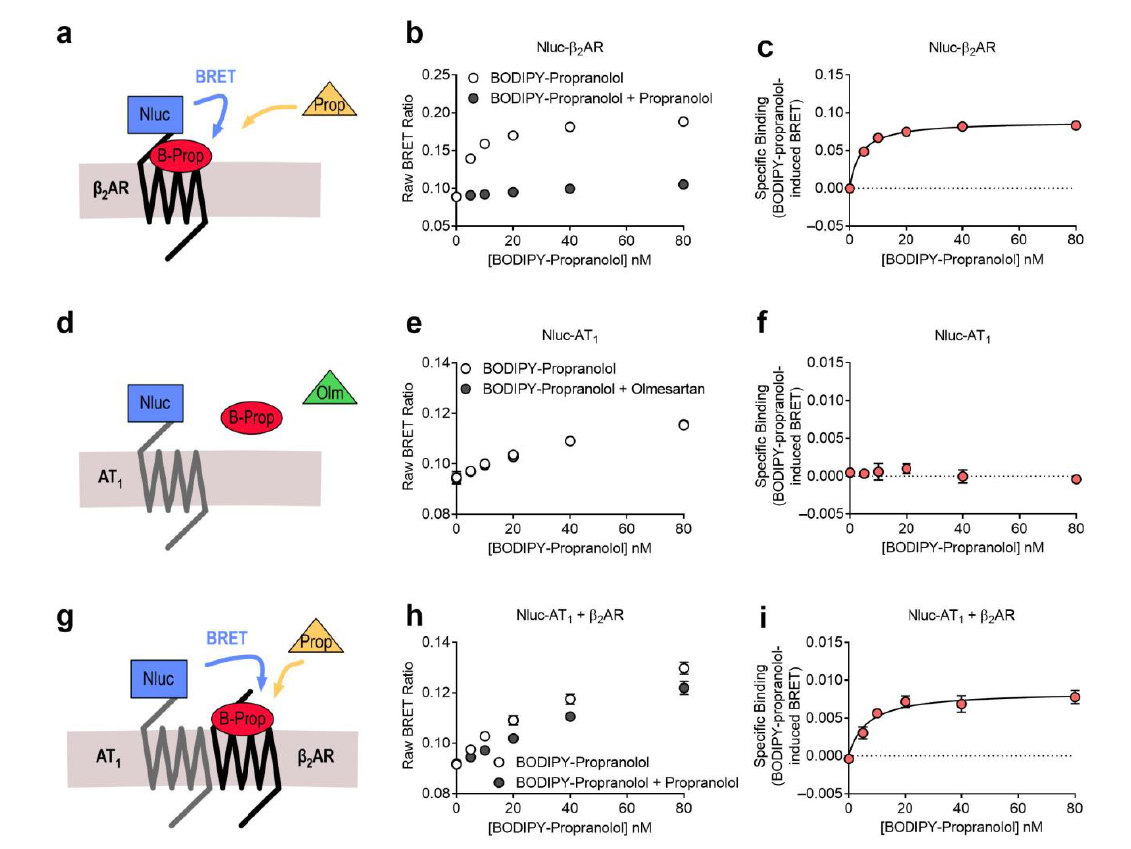
Figure 5. Saturation binding of BODIPY-propranolol to the β 2 AR and the AT 1 - β 2 AR heteromer. Cells expressing Nluc- β 2 AR ( a – c ) or Nluc-AT 1 ( d – f ) or Nluc-AT 1 + β 2 AR ( g – i ) were treated with BODIPY-propranolol (B-Prop) in the presence or absence of 10 µ M propranolol (Prop; a – c , g – i ) or the presence or absence of 1 µ M olmesartan (Olm; d – f ) to generate BODIPY-propranolol total and non-specific binding data ( b , e , h ) and specific binding curves (where possible; c , f , i ). Data are displayed as the raw BRET ratio ( b , e , h ) or specific binding ( c , f , i ), mean ± SEM of three ( e , f ), four ( b , c ) or eight ( h , i ) independent experiments.